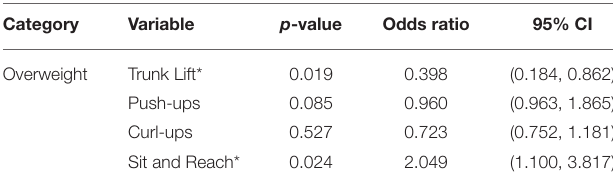
TABLE 4B | Associations between musculoskeletal fitness and weight status in second grade (reference group: